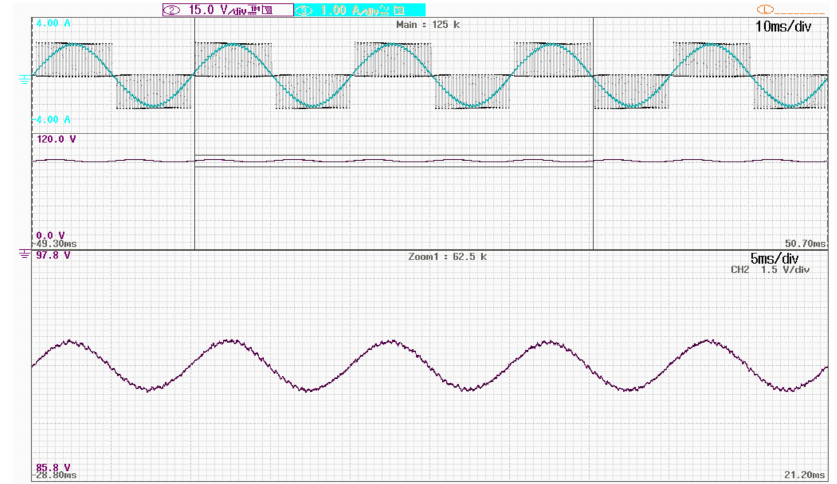
Figure 12. Output load voltage and current: upper part, dc-link voltage: middle part, and zoomed DC-link ripple components: lower part, for m = 0.75 and ϕ = 0 ◦